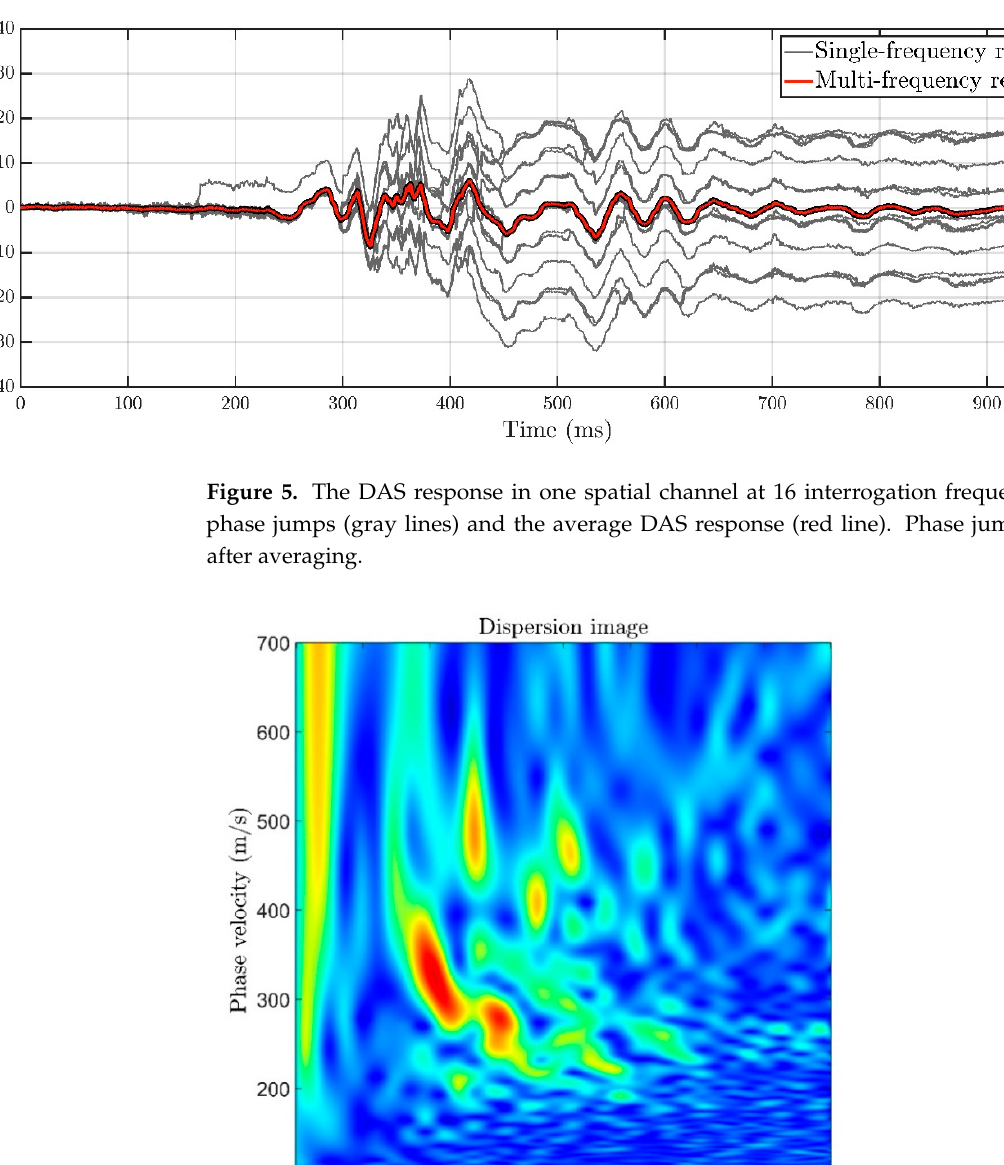
Figure 6. Phase velocity dispersion image of the seismic field record shown in Figure 4. The dark